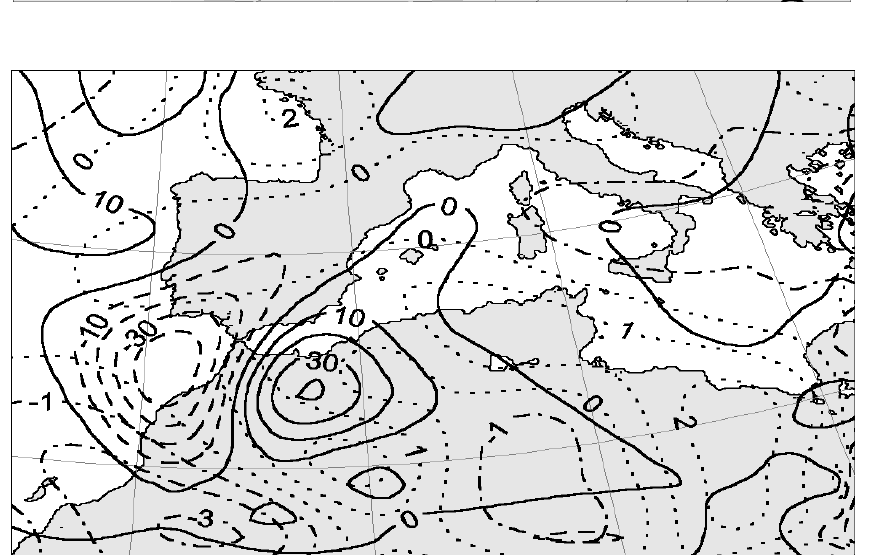
Fig. 12. Precipitable water (mm, thin solid line, with shaded areas in- dicating values greater than 30mm) on 00:00UTC, 23 October 2000, and 24-h averaged water vapor flux conver- gence integrated from 700 to 1000hPa (gm − 2 s − 1 , strong solid line) greater than 200gm − 2 s − 1 ; and 24-h aver- aged latent heat flux (Wm − 2 , dashed line) from 12:00UTC 22 to 12:00UTC, 23 October 2000 shown for domain 2.